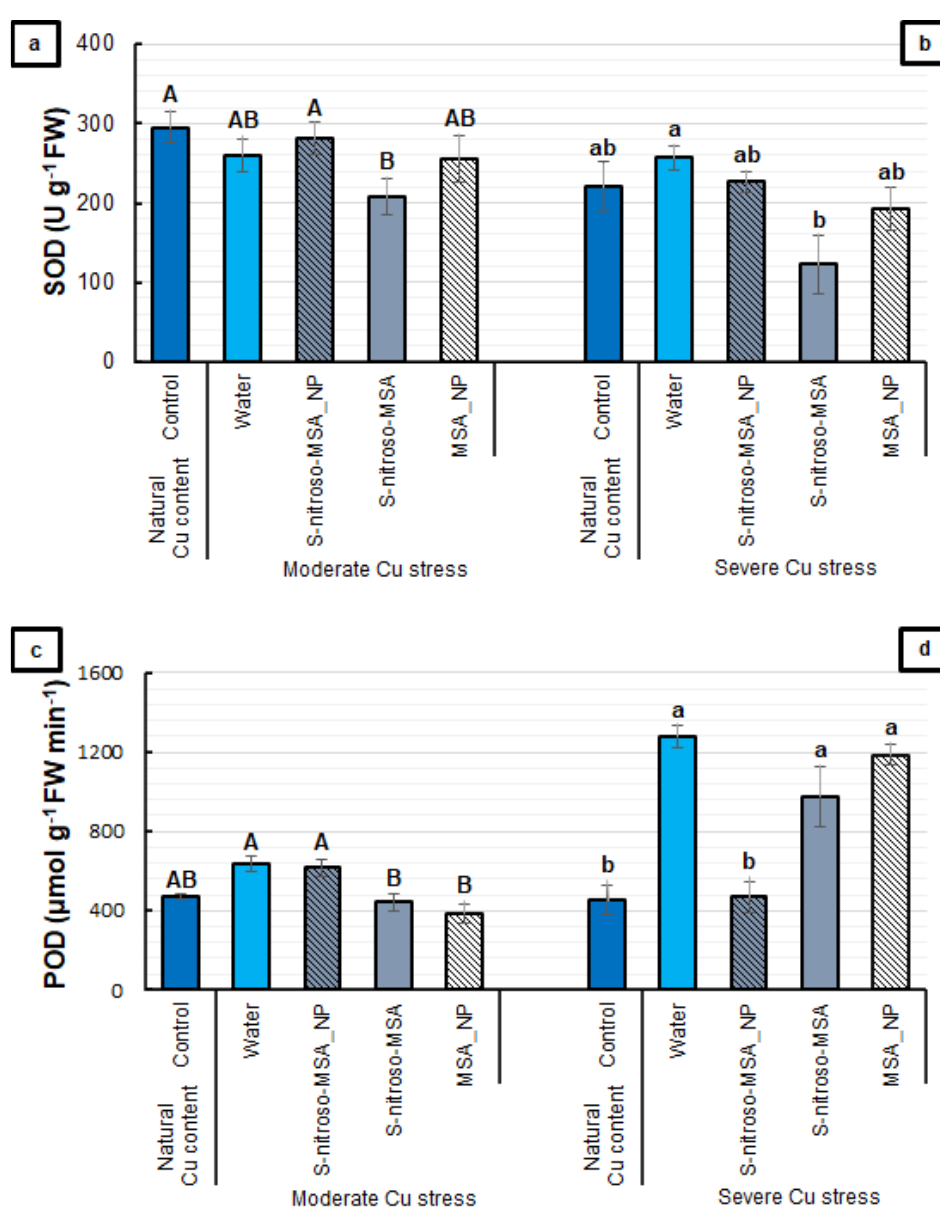
Figure 8. Root superoxide dismutase (SOD) ( a , b ) and peroxidase (POD) ( c , d ) activities of soybean plants cultivated in soil containing different copper (Cu) levels (natural content: 11 mg kg − 1 ; moderate Cu stress: 164 mg kg − 1 ; severe Cu stress: 244 mg kg − 1 ). Control = treatment with distilled water; water = treatment with distilled water after Cu addition; S-nitroso-MSA_NP = treatment with a nanoencapsulated NO donor ( S -nitroso-mercaptosuccinic acid) at 1 mM; S-nitroso-MSA = treatment with a NO donor (S-nitroso-mercaptosuccinic acid) in the free form at 1 mM; MSA_NP = treatment with nanoparticles containing the non-nitrosated MSA at 1 mM. Data are the mean ± standard error ( n = 4). The same uppercase and lowercase letters on the column (referring to experiments 1 and 2, respectively) indicate values that do not differ by ANOVA, followed by the Tukey test ( p < 0.05). For the APX activity, the only effect detected was the decrease induced by MSA_NP,